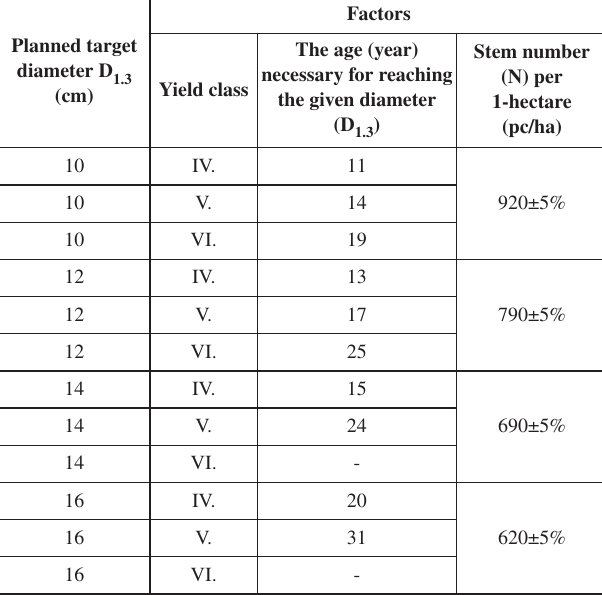
Table 3. Age-target diameter model white poplar stands suitable for production of mass